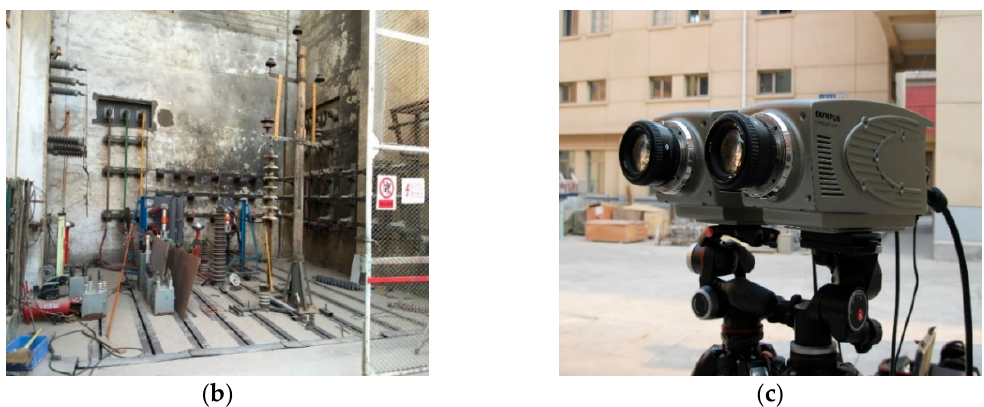
Figure 4. Experimental platform for secondary arc reproduction: ( a ) Experimental circuit; ( b ) Figure4. Experimentalplatformforsecondaryarcreproduction: ( a )Experimentalcircuit; ( b )experiment experiment field; ( c ) high-speed cameras. field; ( c ) high-speed